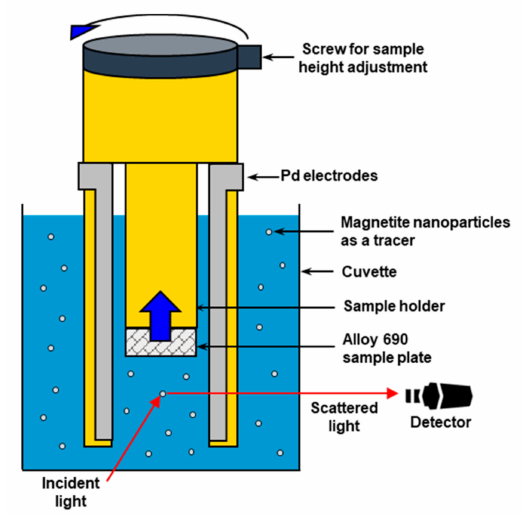
Figure 2. Schematic of a surface zeta potential measurement